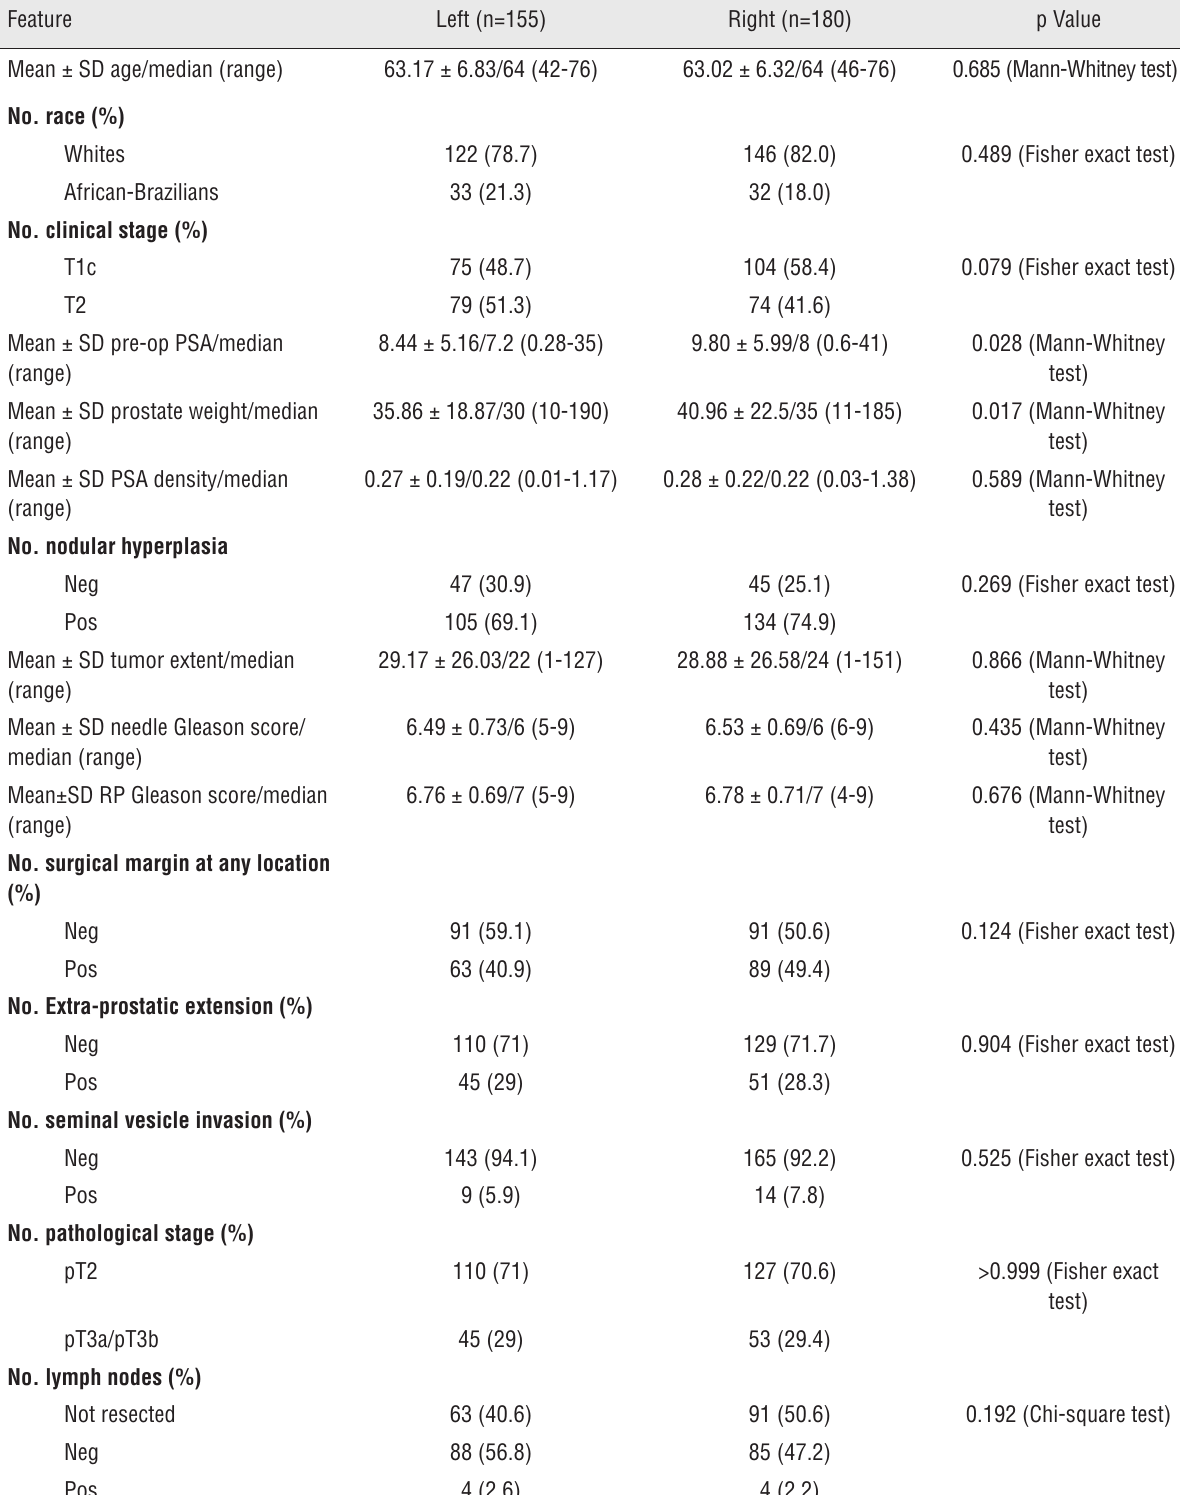
Table 3 - clinicopathological features of 335 patients by index tumor predominant location.